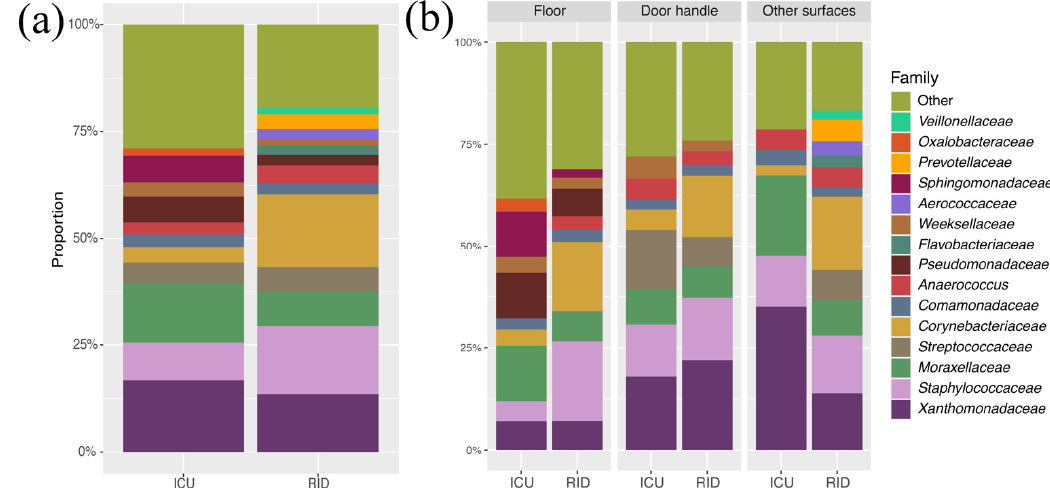
Figure 1. Relative taxonomic distribution at the family level: ( a ) by department; ( b ) by department and surface type. Families with a proportion of <2% are listed as “Other”. ICU—Intensive Care Unit; RID—Respiratory Infections